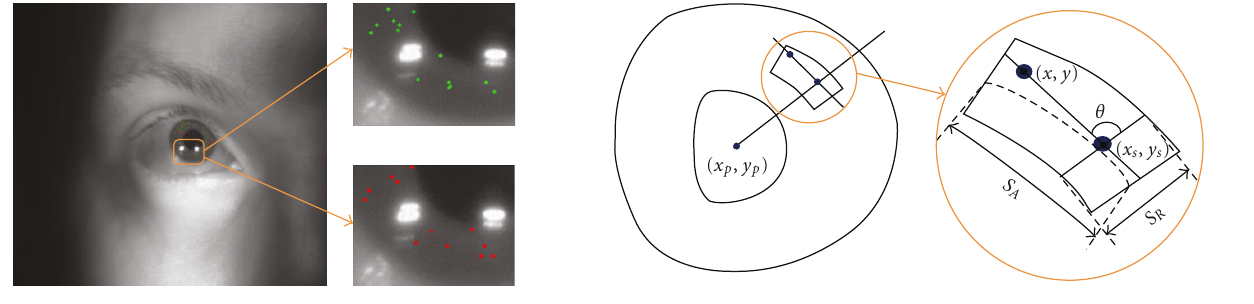
Figure 3: Stable feature points found in two subregion maps in a real image. The left image is an original image with feature points. The top right and bottom right images show the feature points detected in subregion map 1 and subregion map 2, respectively.